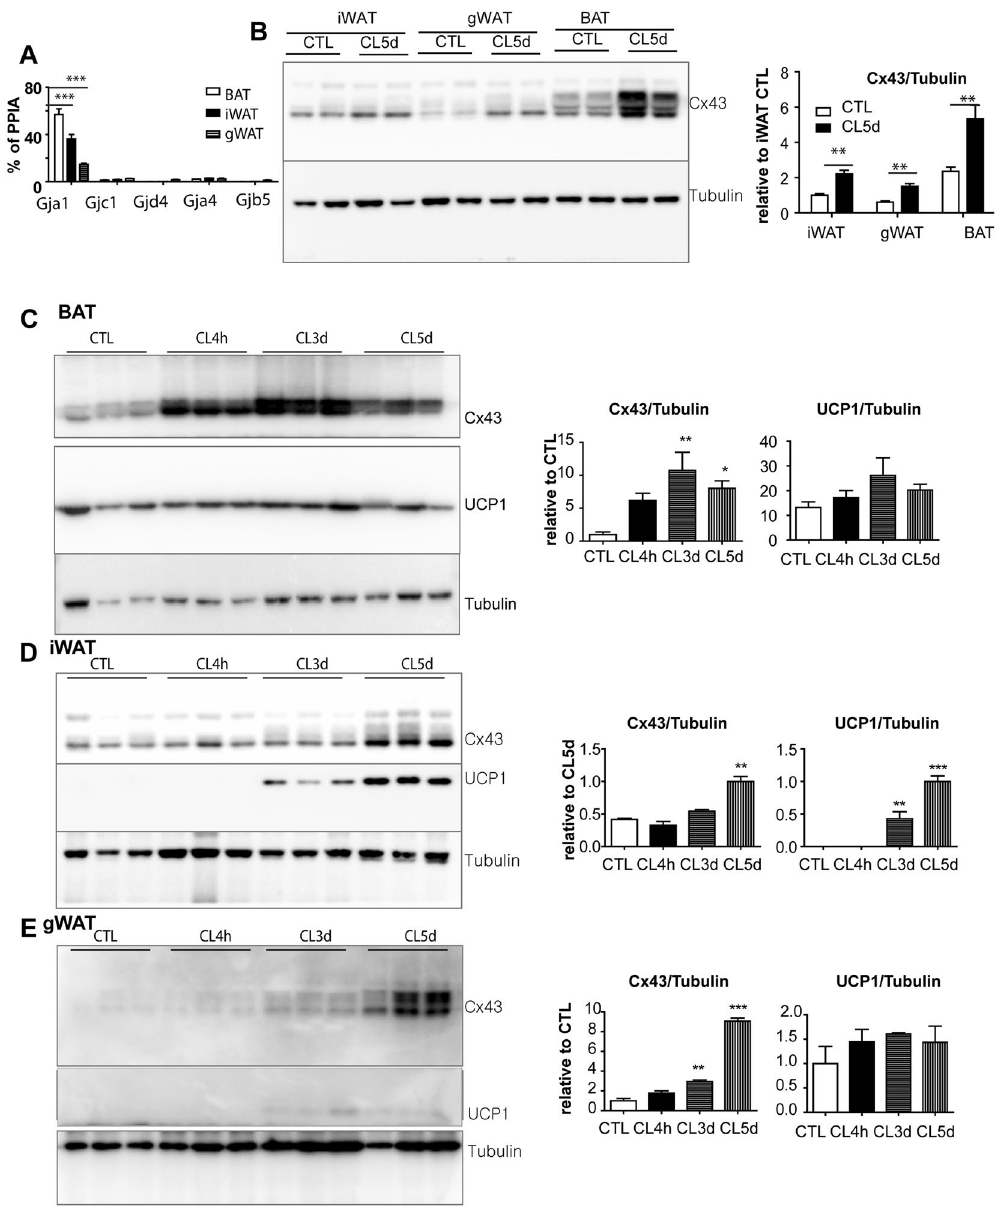
Figure 1. β 3-adrenergic stimulation induces Cx43 expression in brown and white adipose tissue. ( A ) qPCR analysis of connexin expression levels in BAT (brown adipose tissue), iWAT (inguinal white adipose tissue), and gWAT (gonadal white adipose tissue) (mean ± S.E.M.; n = 3 per condition, *** P < 0.001). ( B–E ) Immunoblot analysis and quantification of Cx43 and UCP1 expression in BAT, iWAT and gWAT of mice treated with CL up to 5 days. Tubulin was used as a loading control. (mean ± S.E.M.; n = 4 per condition, * p < 0.05, ** p < 0.01, *** p < 0.001) (Immunoblots accompanied by size markers in Fig.